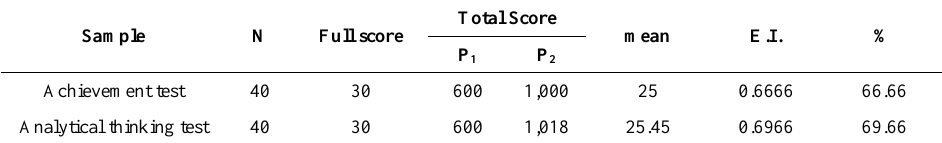
Table 2. Student achievement testing and analytical thinking testing results